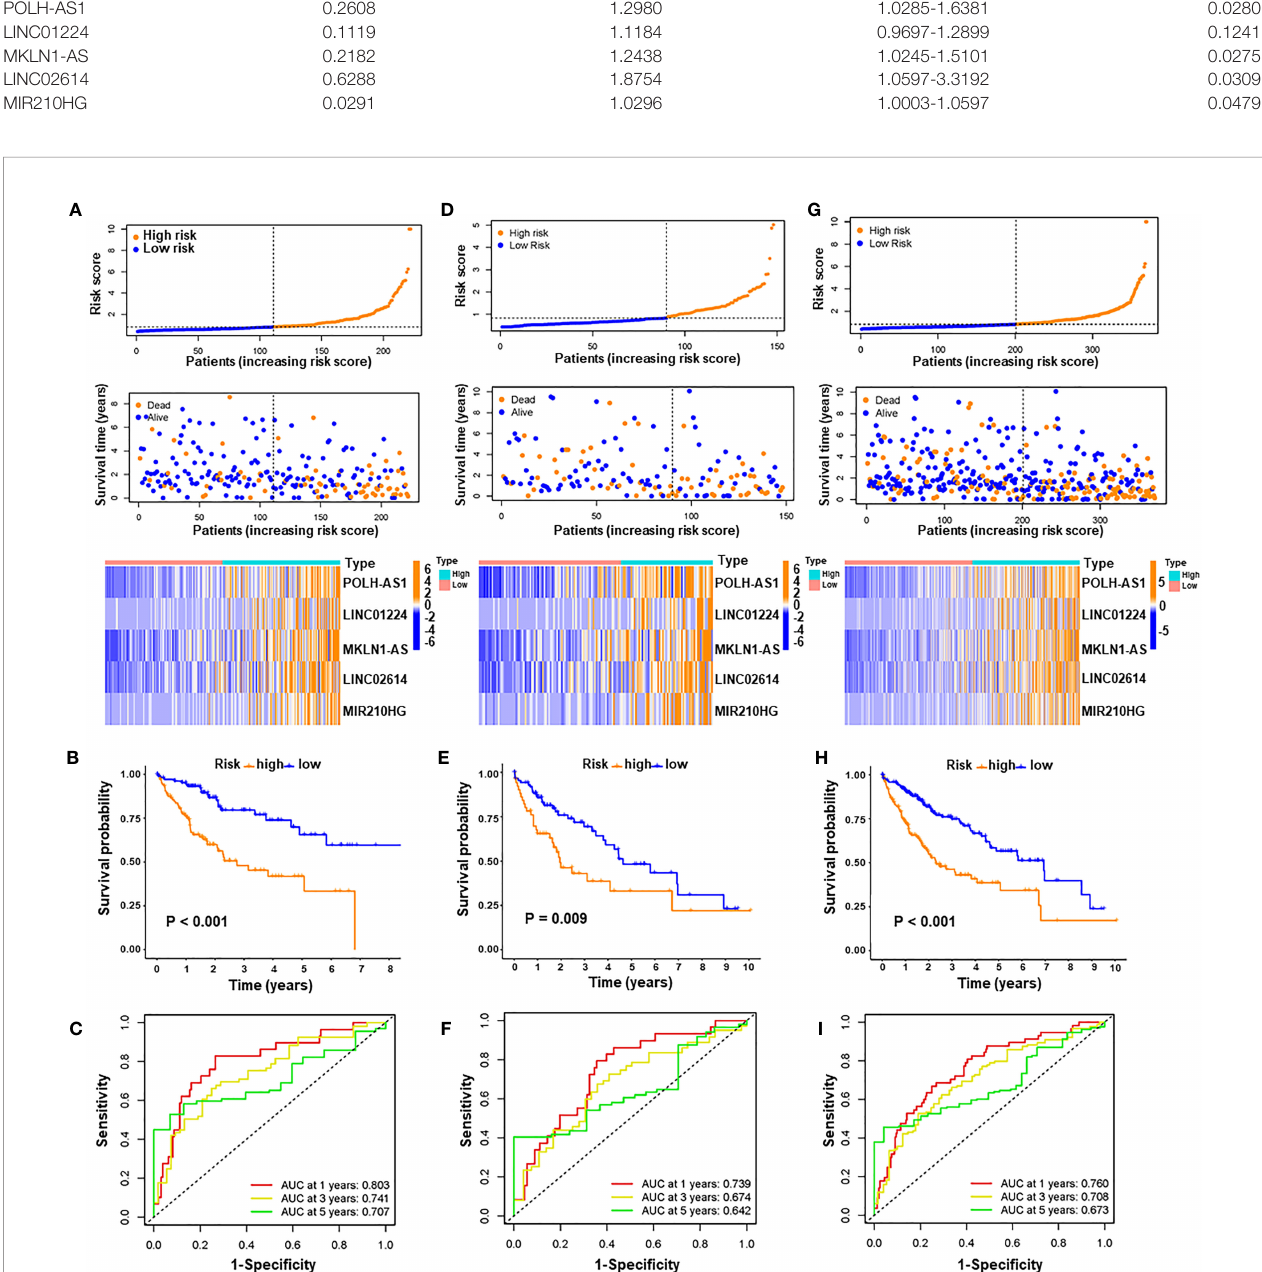
FIGURE 4 | Evaluation and validation of pyroptosis-related lncRNA signature for overall survival in patients with HCC in three datasets. Risk scores and expression pro fi les of fi ve-lncRNA signature in the high- and low-risk groups showed in the training cohort (A) , testing cohort (D) , and entire cohort (G) . Kaplan – Meier survival and ROC analyses in the training cohort (B, C) , testing cohort (E, F) , and entire cohort (H, I) ,